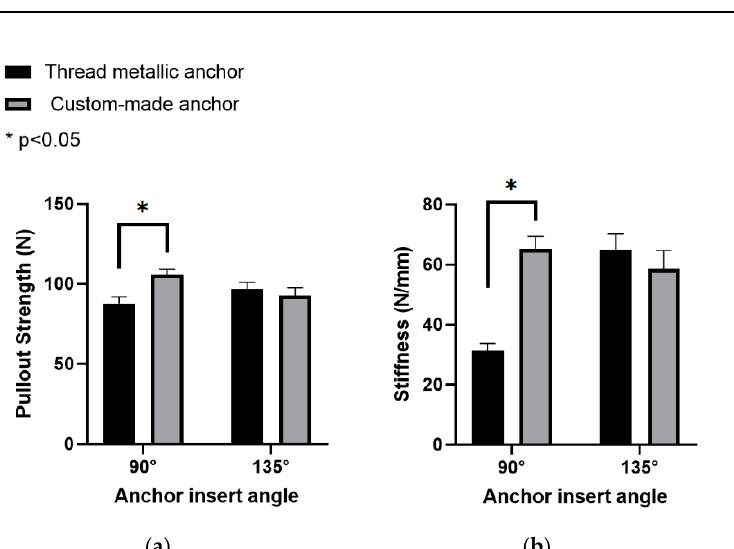
Table 2. Percentage of specimens intact (survived) after cyclic